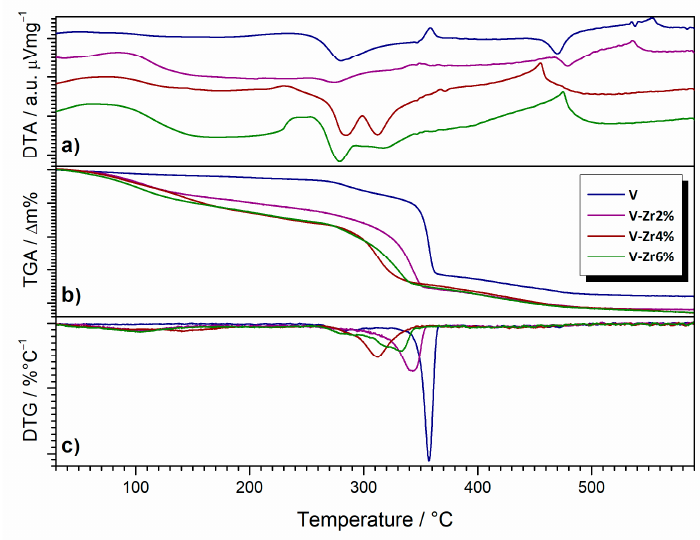
Figure 9. ( a ) DTA, ( b ) TGA, and ( c ) DTGA curves of the pure V to V-Zr6% samples.